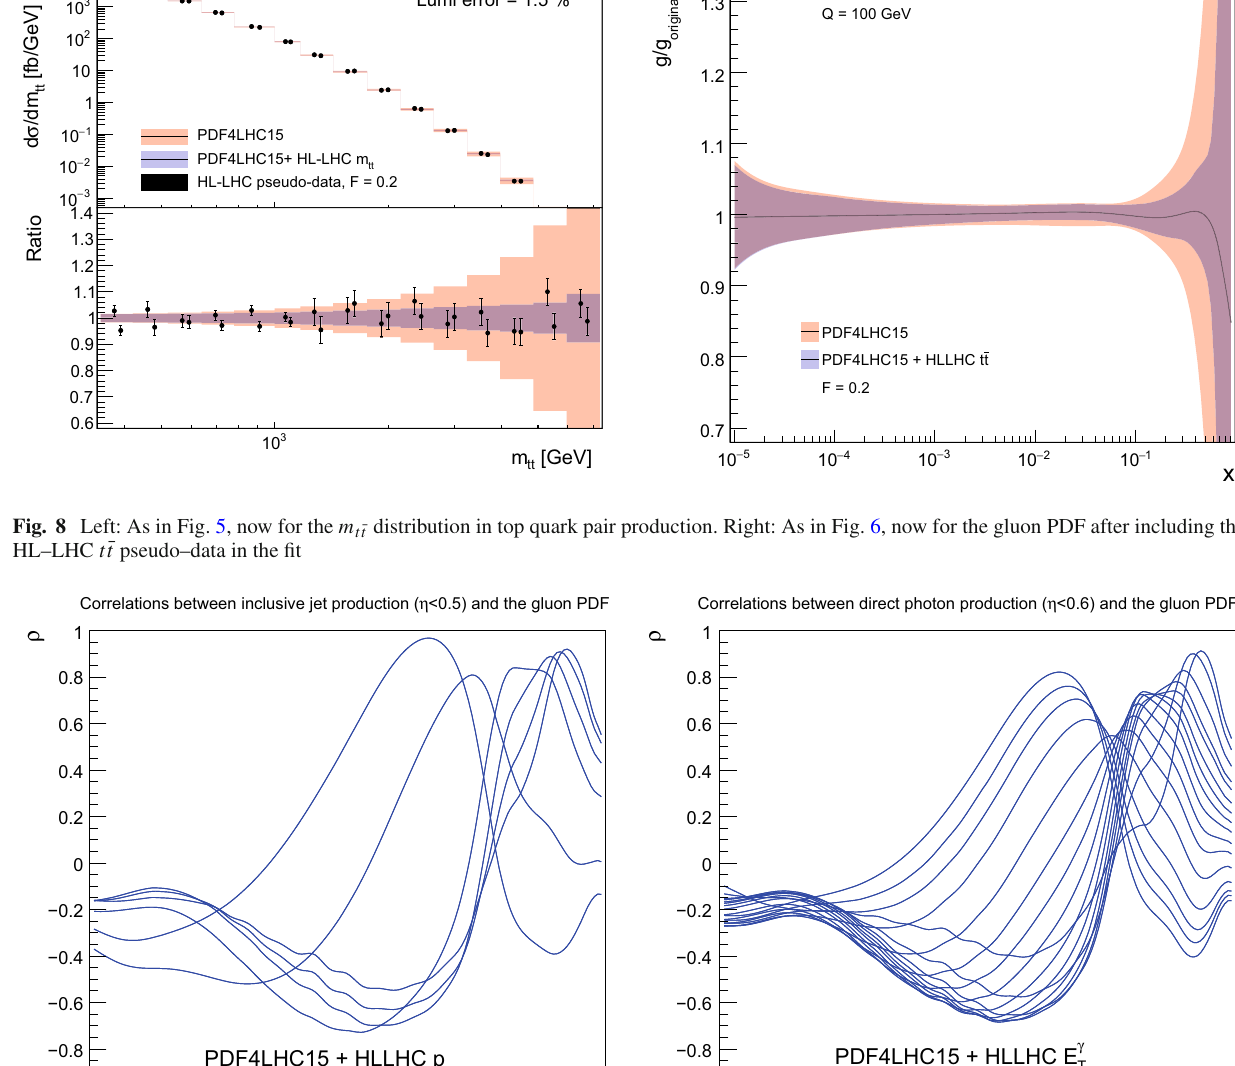
−1−0.8−0.6−0.4−0.200.20.40.60.81 PDF4LHC15 + HLLHC E